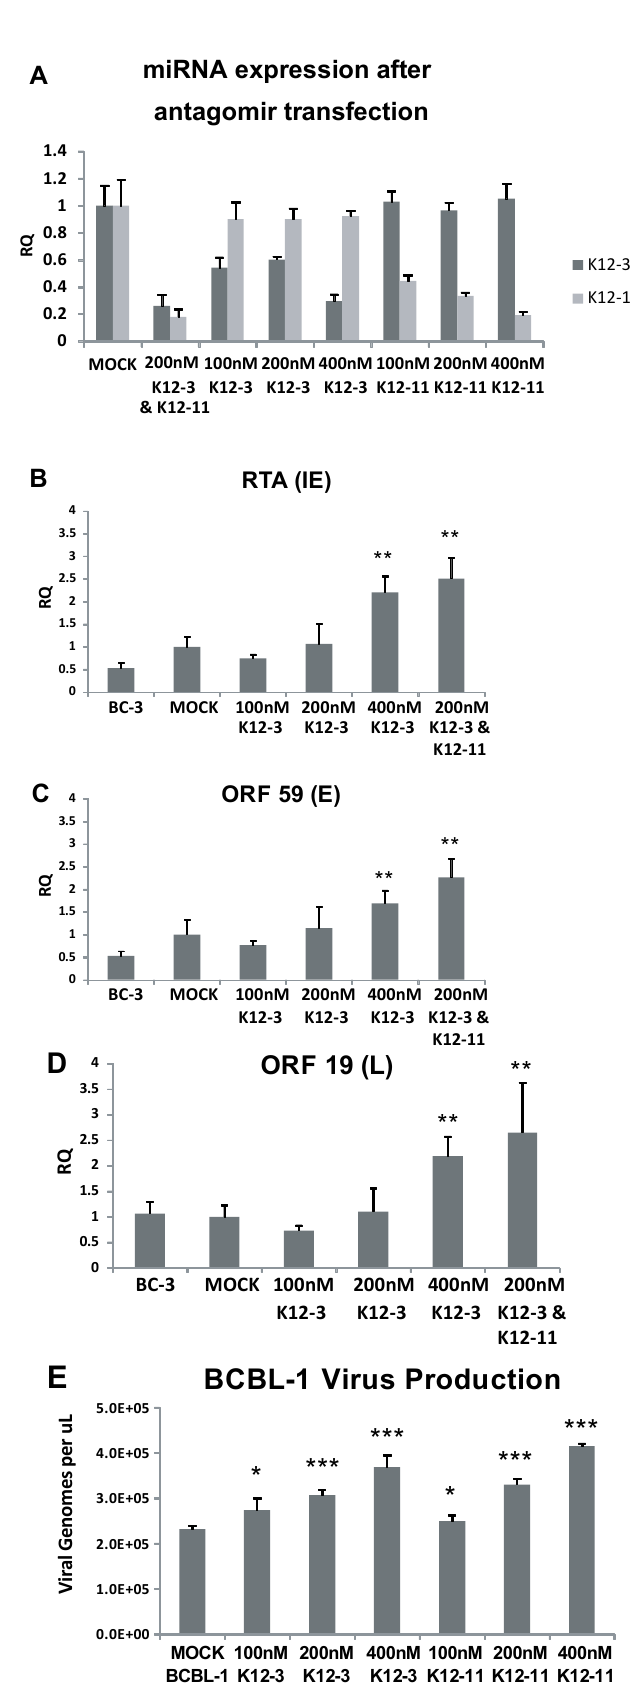
Figure 1. Lytic gene expression and virus production following miR-K12-3 and miR-K12-11 knockdown in PEL cells. ( A ) Confirmation of miRNA knockdown after antagomir transfection. BCBL-1 cells were transfected with the indicated amounts of miR-K12-3